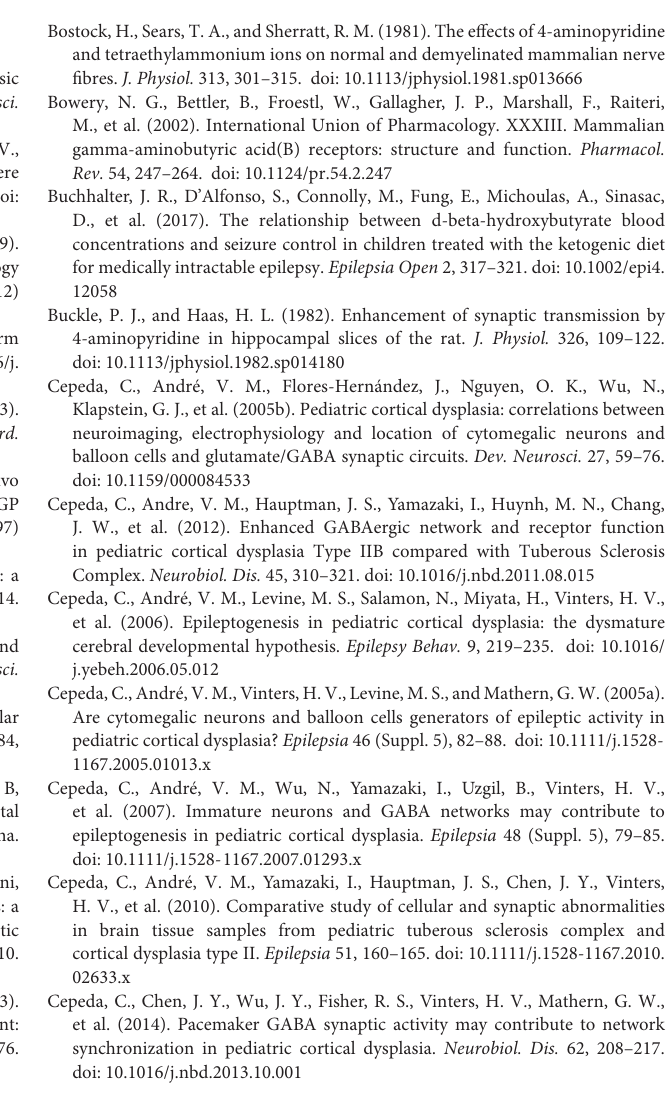
FIGURE S3 | BIC inverts the polarity of 4-AP oscillations. (A) In the presence of BIC, 4-AP oscillations were depolarizing and accompanied by action potentials. After addition of BIC to the bath solution, the oscillations reversed polarity and became hyperpolarizing. (B) In this CPN 4-AP oscillations were biphasic (hyperpolarization followed by depolarization). After BIC, the oscillation was purely hyperpolarizing and inhibitory at two membrane potentials. Notice that the action potentials in the upper panels are truncated. FIGURE S4 | Phaclofen enhances paroxysmal discharges in the zero Mg 2 + model. (A) In this CPN from a CD type II case, removal of Mg 2 + from the external solution increased cell excitability as reflected by spontaneous firing. (B) Addition of BIC induced rhythmic paroxysmal discharges. (C) After phaclofen burst duration was significantly increased. FIGURE S5 | Enriched ACSF (BHB and pyruvate) blocks 4-AP oscillations. (A) A CPN was recorded and filled with biocytin. (B) In voltage clamp mode, at a + 10 mV holding potential, spontaneous GABA synaptic activity was observed. After 4-AP, rhythmic oscillations (outward currents) were induced. A few minutes after switching the bathing solution to eACSF, 4-AP oscillations were abated. After wash out in normal ACSF, some 4-AP oscillations